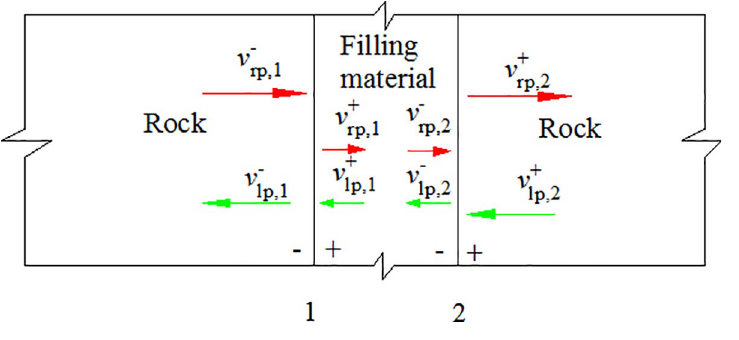
Fig 2. Filled joint